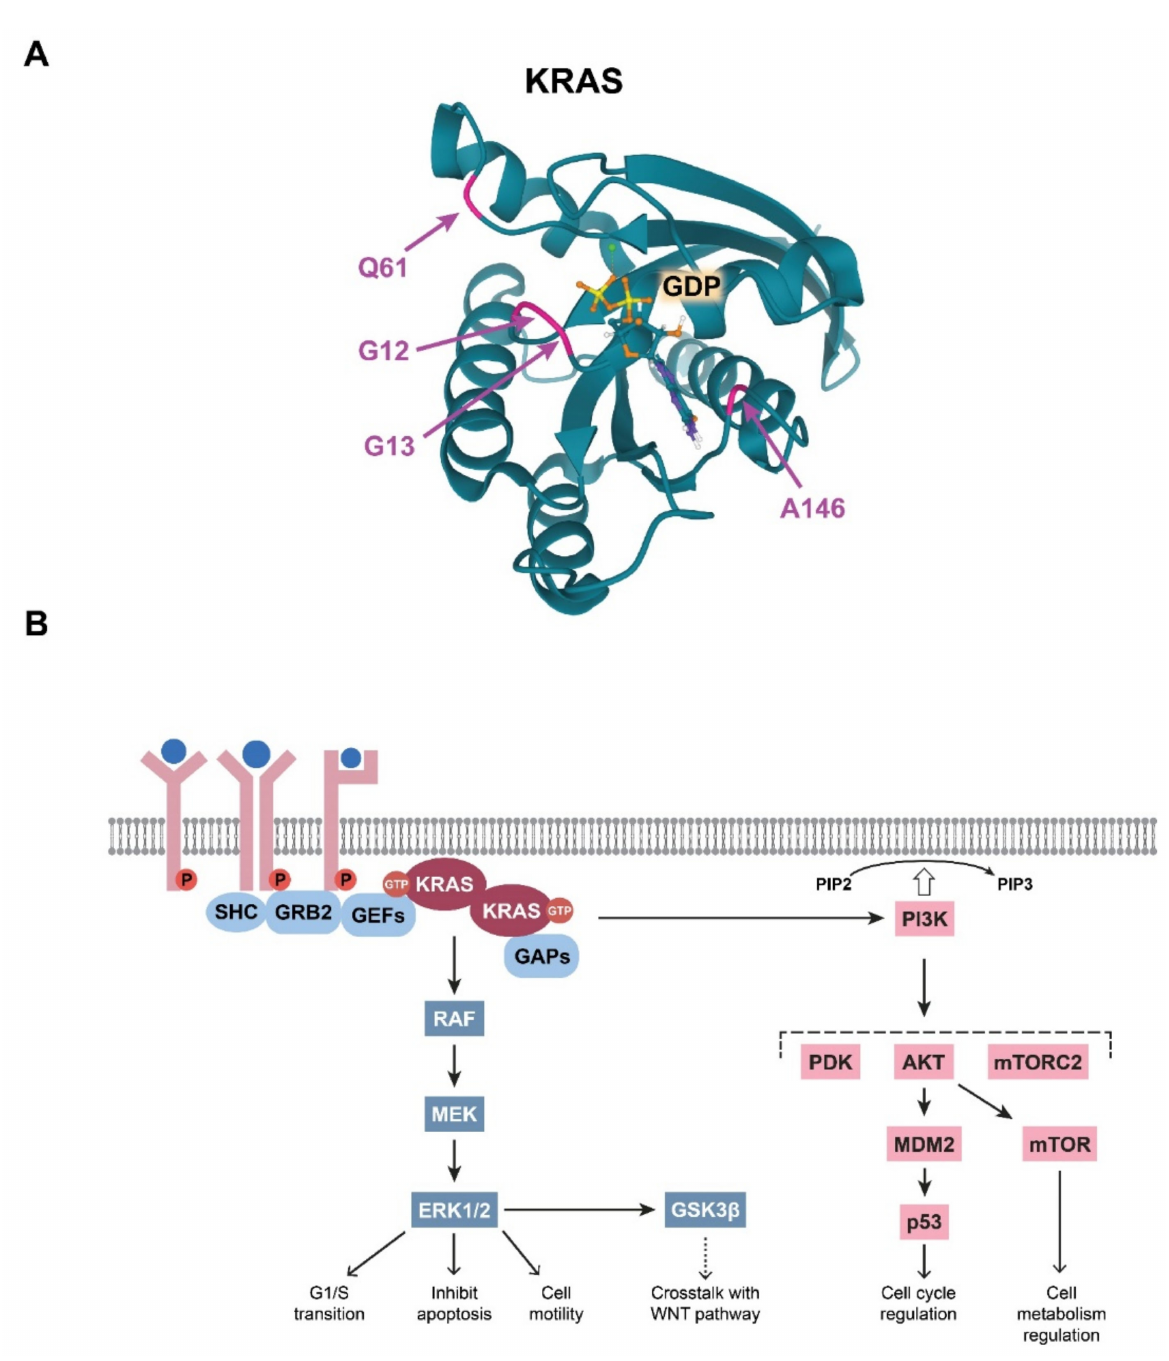
Figure 2. ( A ) Visualisation of the colorectal cancer (CRC)-related mutations in the KRAS G domain. The glutamine residue at position 61, the glycine residues at positions at 12 and 13, and the alanine residue at position 146, which form the GDP/GTP pocket, are indicated with colours. Image from the RCSB PDB (rcsb.org (accessed on 3 March 2021)) of PDB ID: 6MBT [22]. ( B ) Schematic representation of the summary of the RAS-driven signalling